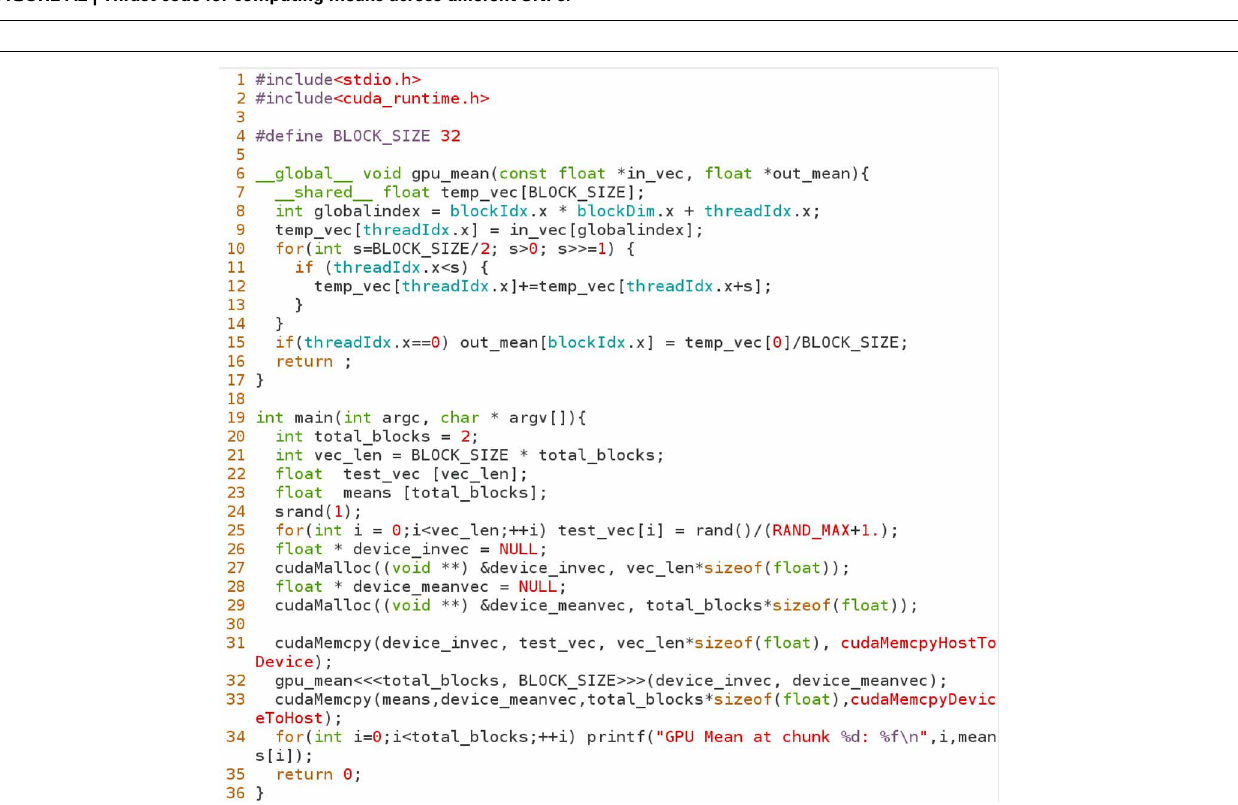
FIGURE A2 | Thrust code for computing means across different SNPs.